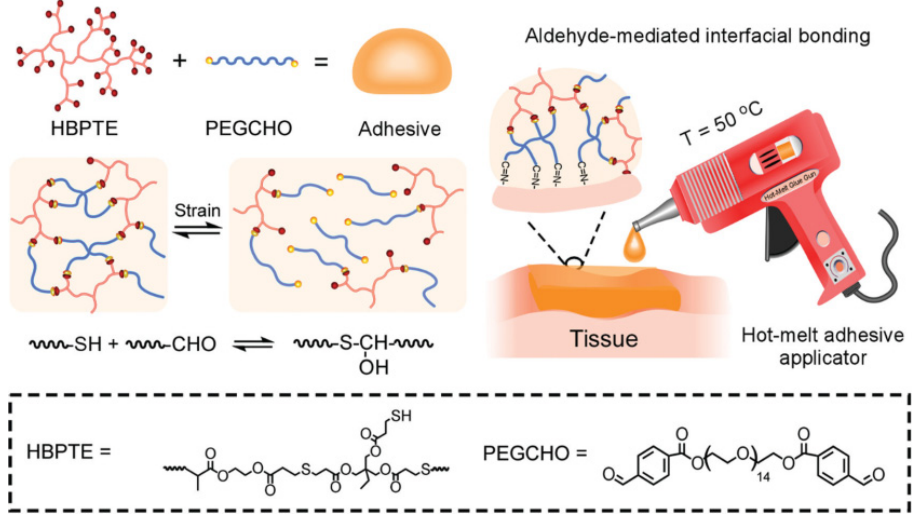
Figure 29. Schematic illustration of the fabrication of solvent-free adhesive using the dynamic thiol–aldehyde crosslinking chemistry and its administration using a hot-melt adhesive applicator. Reproduced with permission from [272]. Copyright: Royal Society of Chemistry.